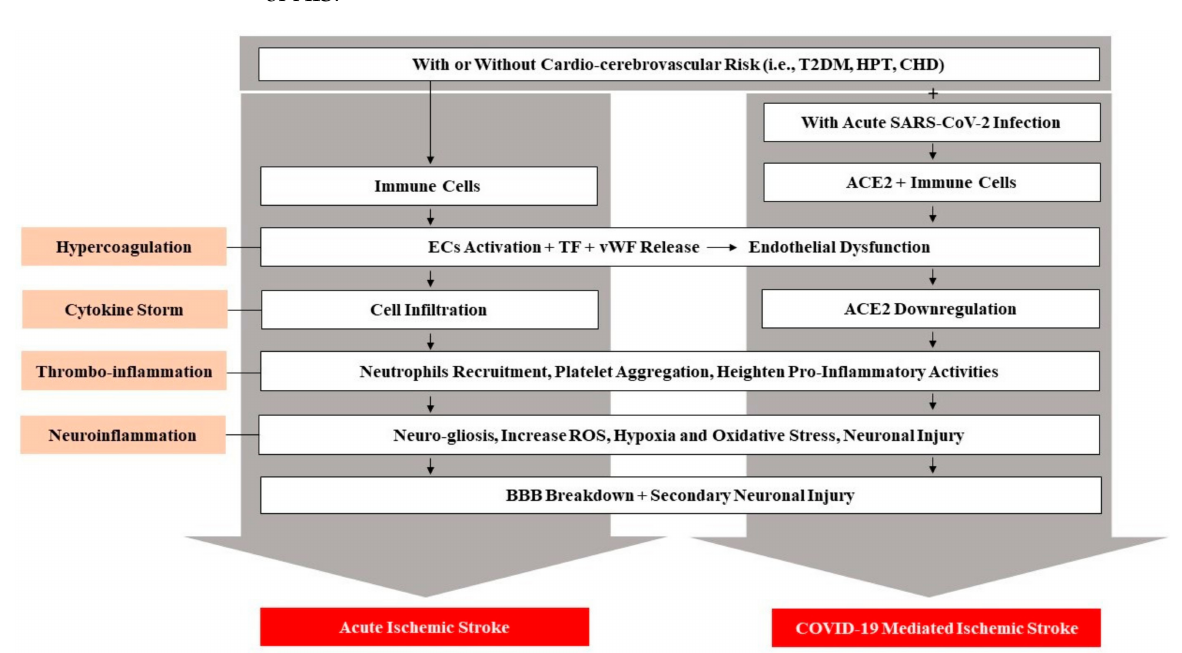
Figure 1. Pathophysiological mechanism of COVID-19-mediated ischemic stroke and its common or shared features with that of AIS. ACE2, angiotensin-converting enzyme 2; CHD, coronary heart disease; ECs, endothelial cells; HPT, hypertension; ROS, reactive oxygen species; T2DM, type 2 diabetes mellitus; TF, tissue factors; vWF, von Willebrand